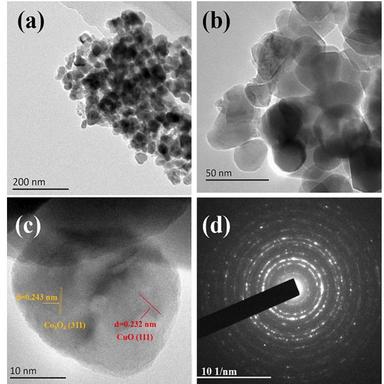
TEM images and SAED pattern of the 5%Cu2+-Co3O4/NC-GL-600 material.